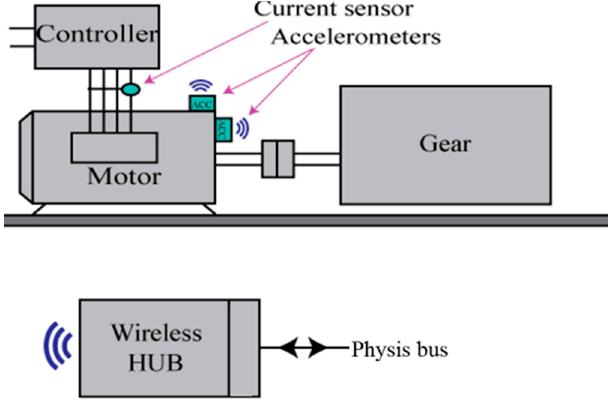
Figure 17. Setup for actuator condition monitoring.